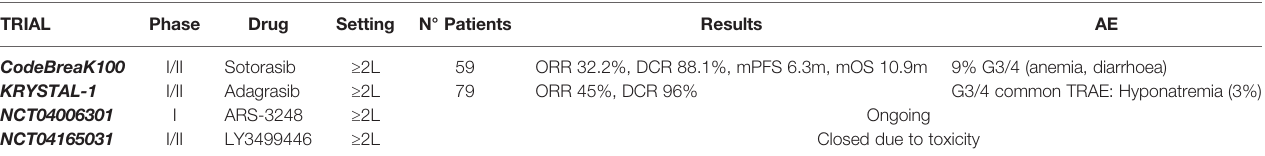
TABLE 3 | KRAS G12C direct